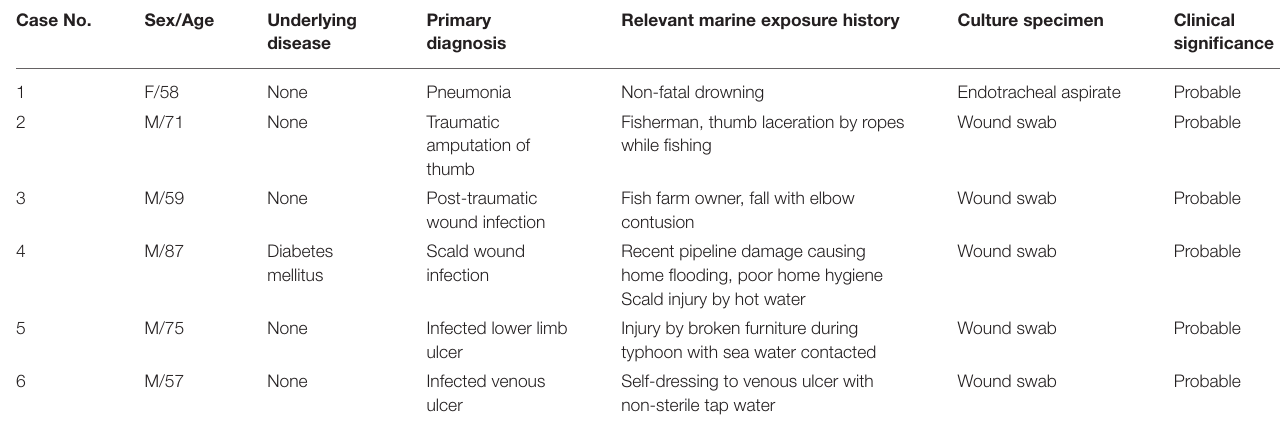
TABLE 4 | Cases with marine exposure. Case